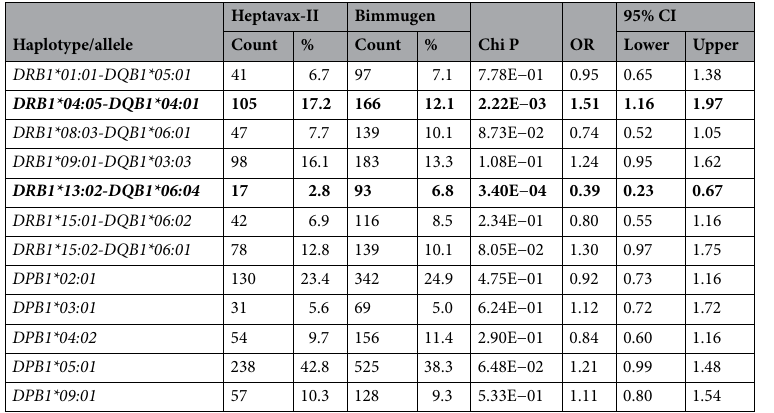
Table 2. Associations of HLA class II genes in individuals with a high response (HBsAb > 100 mIU/mL) to Heptavax-II and Bimmugen vaccines. The estimated DRB1-DQB1 haplotype frequencies over 5.0% and DPB1 allele frequencies over 5.0% in individuals vaccinated with Bimmugen are shown. The total number of high- responders in Heptavax-II and Bimmugen was 278 and 686, respectively, for the DPB1 allele and 305 and 686, respectively, for the DRB1-DQB1 haplotype. Significance level (α) in HLA association analysis was determined by the sorting test, with P < 0.00368 for the DRB1-DQB1 haplotype and P < 0.00820 for the DPB1 allele. P values and odds ratios (OR) were calculated by Pearson’s chi-square test for presence vs. absence of each allele. P values and OR that were statistically significant after correction are indicated in bold.